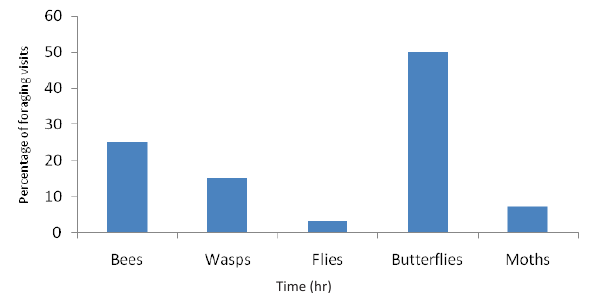
Figure 8. Percentage of foraging visits of different categories of insects on Syzygium